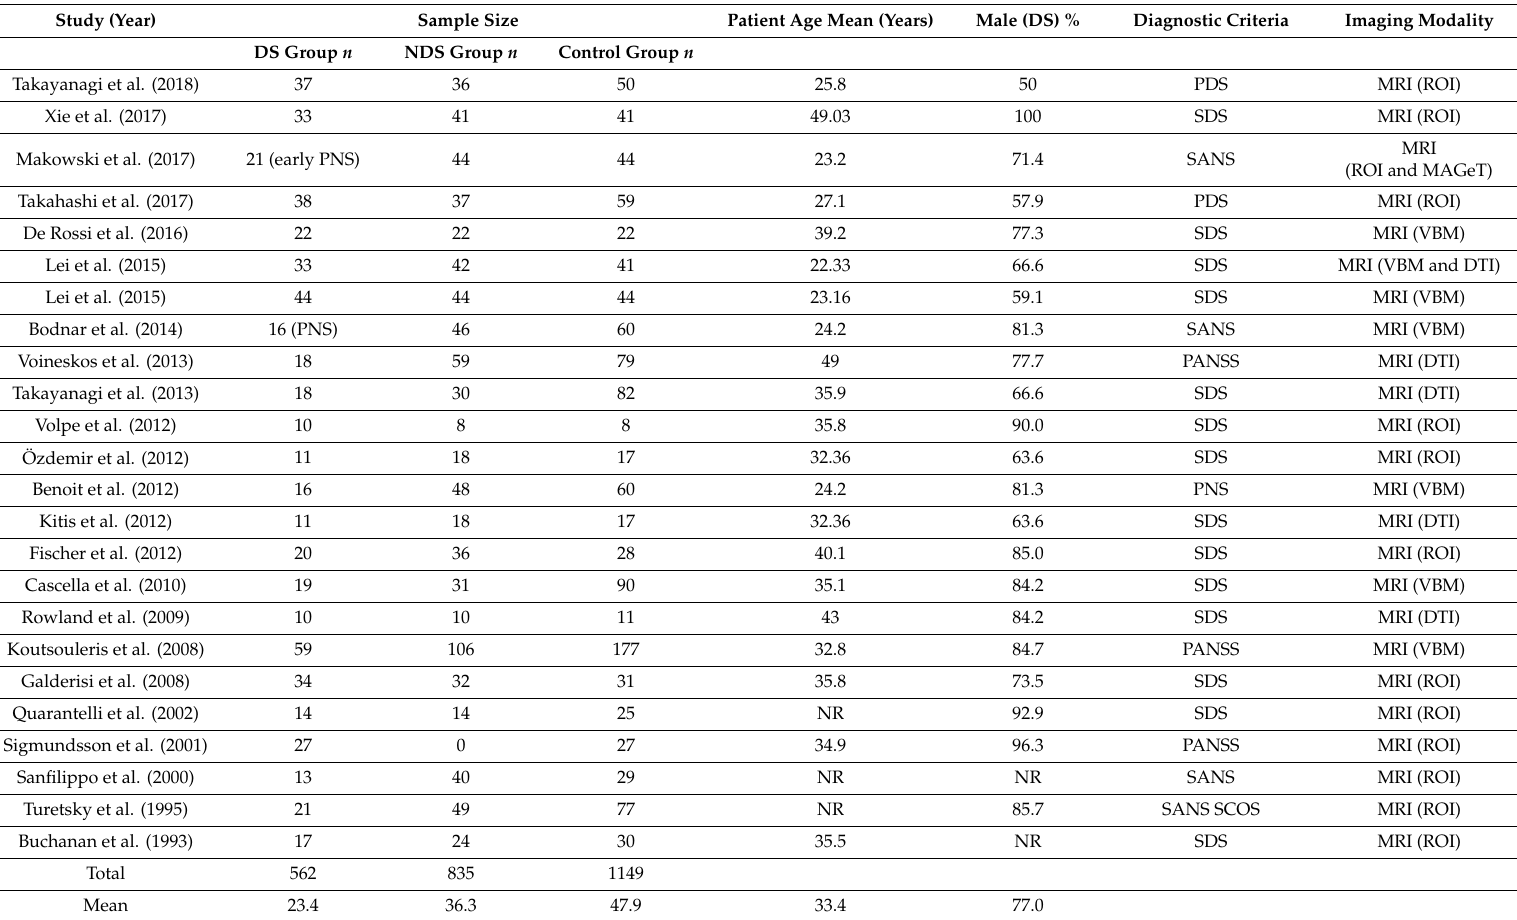
Table 1. Summary of studies included in systematic review and